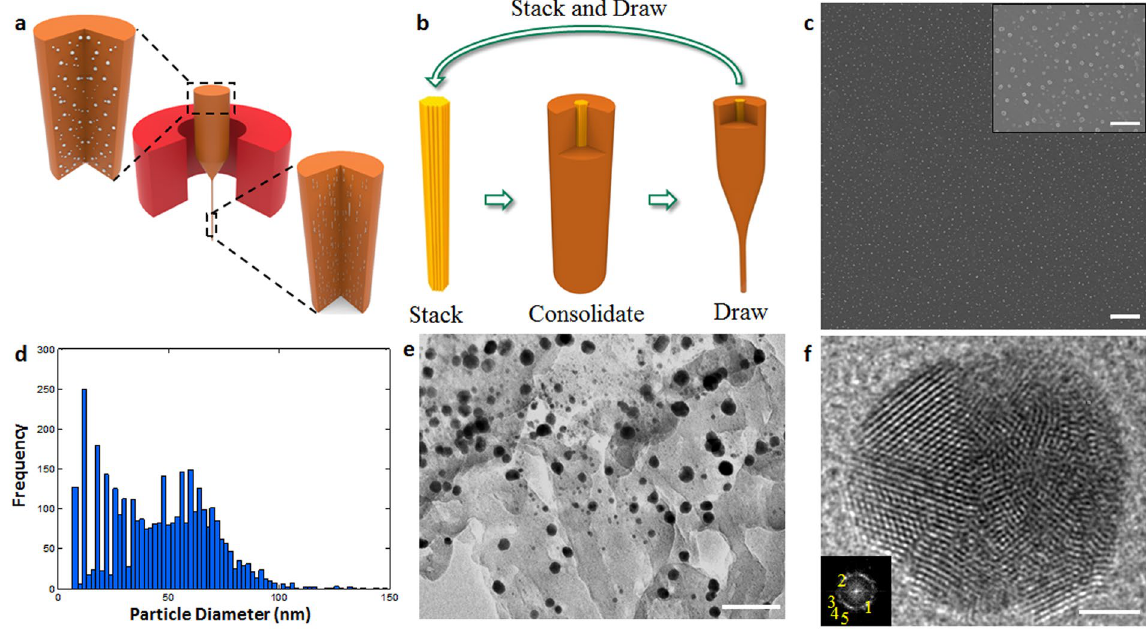
Figure 2. PES-5Sn nanocomposites by thermal drawing. ( a ) Schematic of the thermal drawing process. ( b ) Schematic of the stack and draw iteration. ( c ) SEM image of the longitudinal cross-section of PES- 5Sn nanocomposite fiber with an inset to show high magnification (scale bar: 2 μ m, inset: 500 nm). ( d ) Sn nanoparticle size distribution in PES-5Sn nanocomposites fiber (after the third cycle of the thermal drawing). ( e ) TEM image of Sn nanoparticles when PES cladding is dissolved after the third cycle of thermal drawing (scale bar: 50 nm). ( f ) Atomic resolution TEM image of Sn twinned-nanoparticles with polygonal shapes showing many facets as confirmed by their ring patterns (insets) (see Supplemental Table 2 for indexed diffraction patterns) (scale bar: 2 nm).